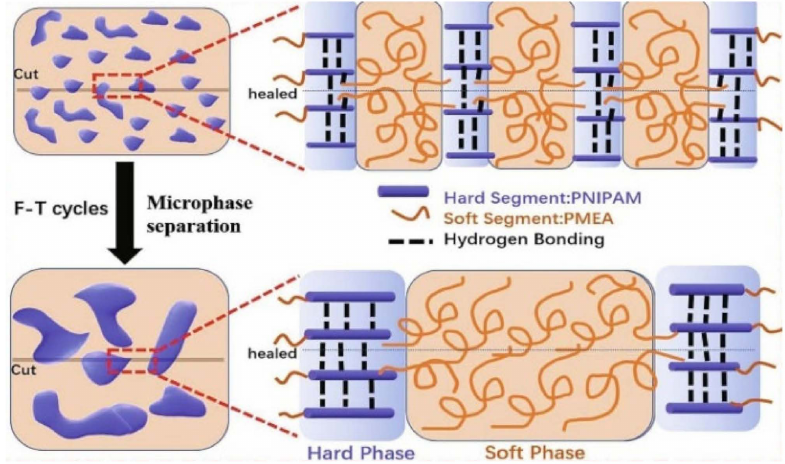
Figure 6. The proposed self-healing mechanism based on the reversible H-bonds and microphase separation structures. Reproduced from [122] with permission from